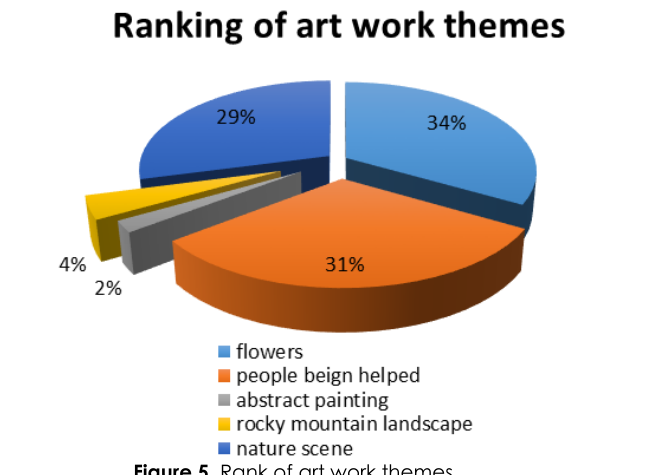
Figure 5. Rank of art work